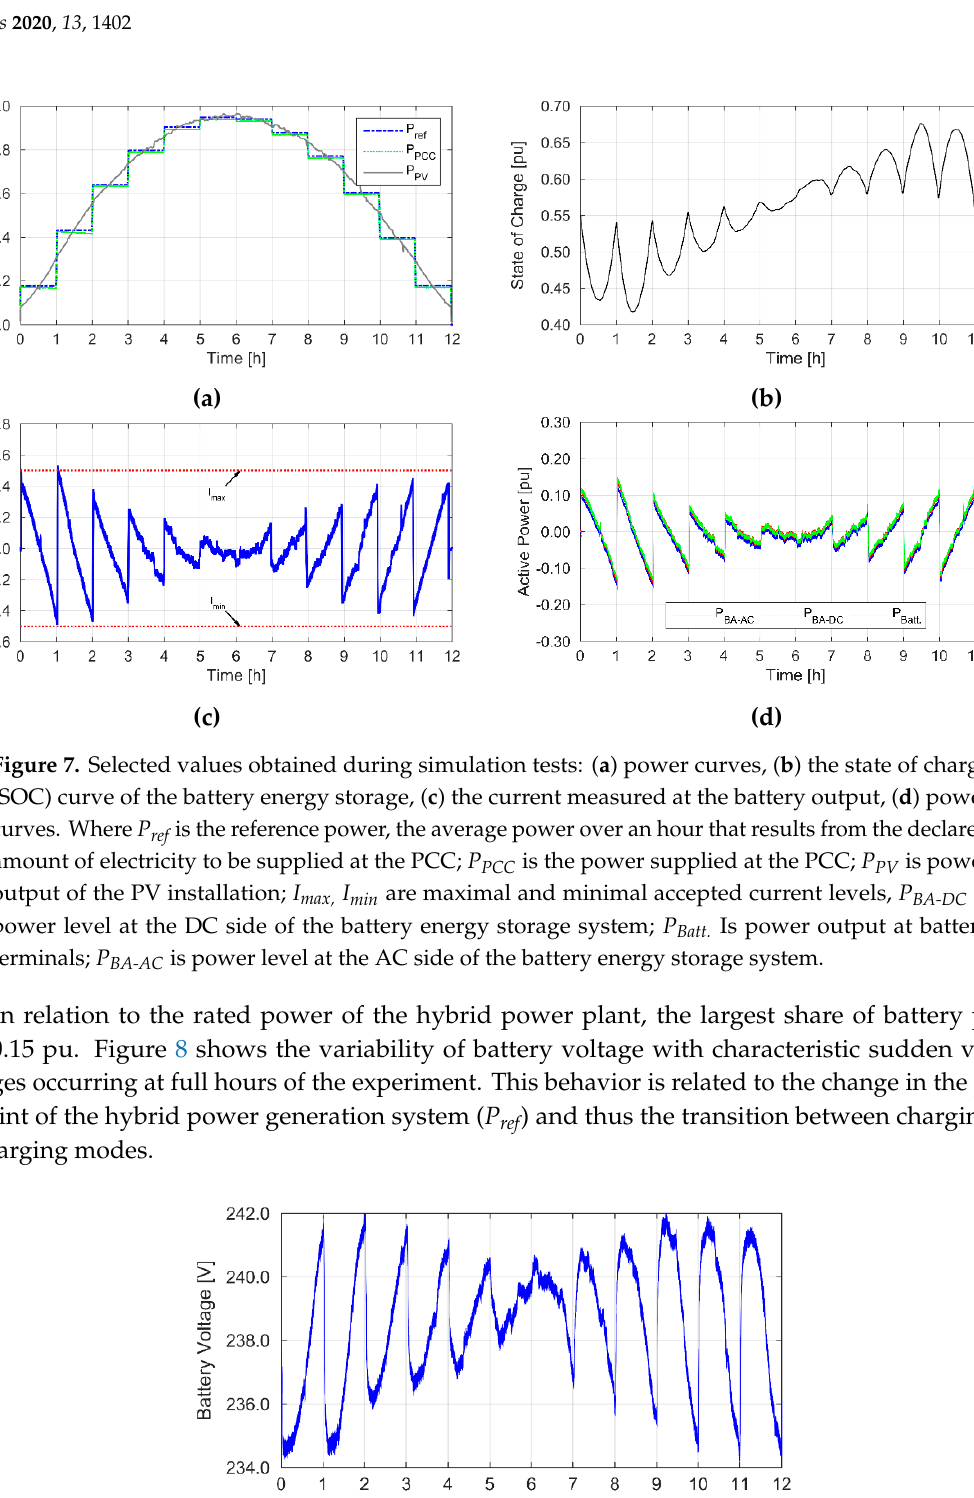
Figure 8. Battery voltage waveform.